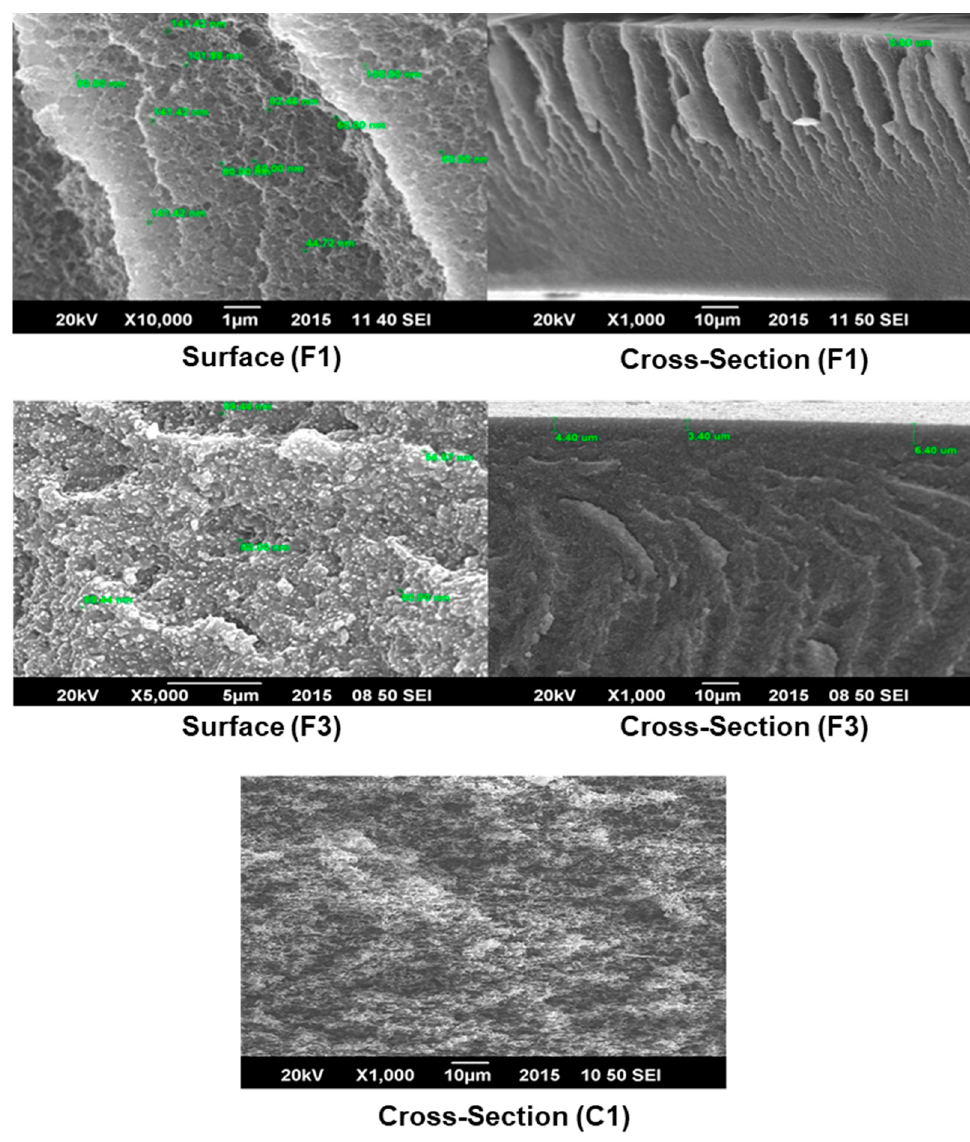
Figure 2. SEM images of surface and cross-section of the Formic-Acid-based membranes (F1 and F3) and commercial membrane (C1).